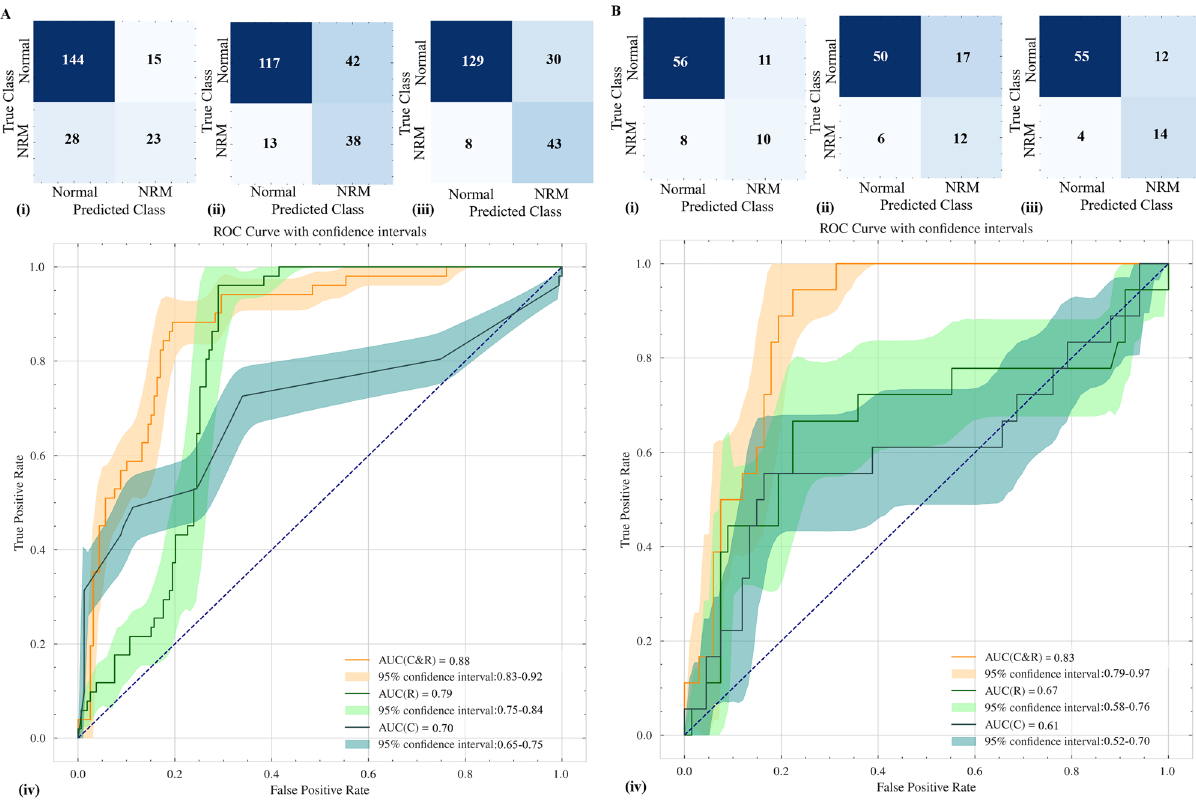
Figure 2. The confusion matrix and ROC curve for predicting neonatal respiratory morbidity depending on different features. ( A ) Results of the training set; ( B ) results of the testing set; (i), (ii) and (iii): confusion matrix; (iv): ROC curves. (i): Results of the model based on clinical features. (ii) Results of the model based on radiomics features. (iii) Results of the model based on the combination of clinical and radiomics features. NRM neonatal respiratory morbidity, ROC receiver operating characteristic curve, AUC area under the receiver- operating-characteristics curve, C clinical features, R radiomics features; C&R the combination of clinical and radiomics features.